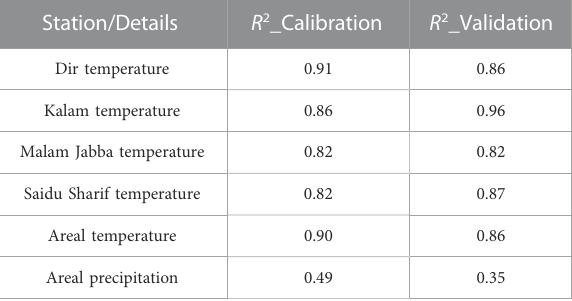
TABLE 4 Details of monthly coef fi cient of determination for calibration/ validation